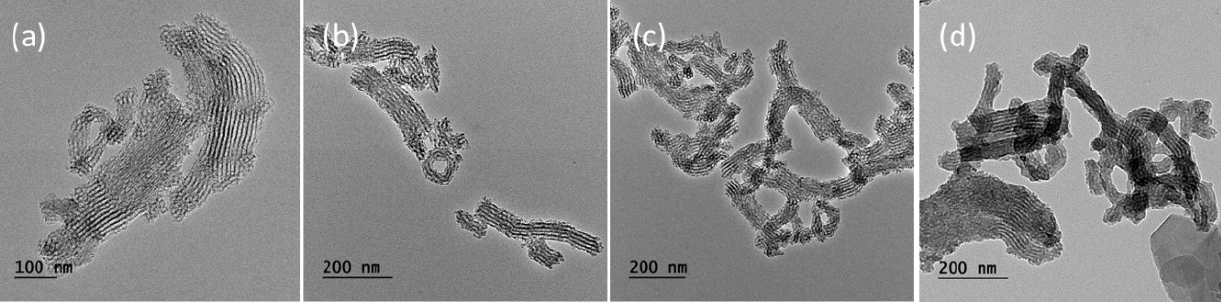
Figure 2. Transmission electron microscopic images of IBN-4 nanoparticles: ( a ) As-synthesized